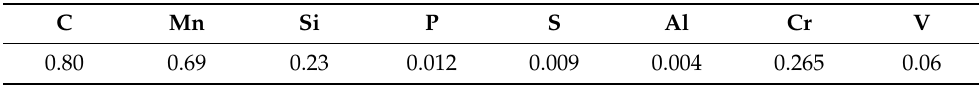
Table 1. Chemical composition of the steel (wt%; the balance is Fe).